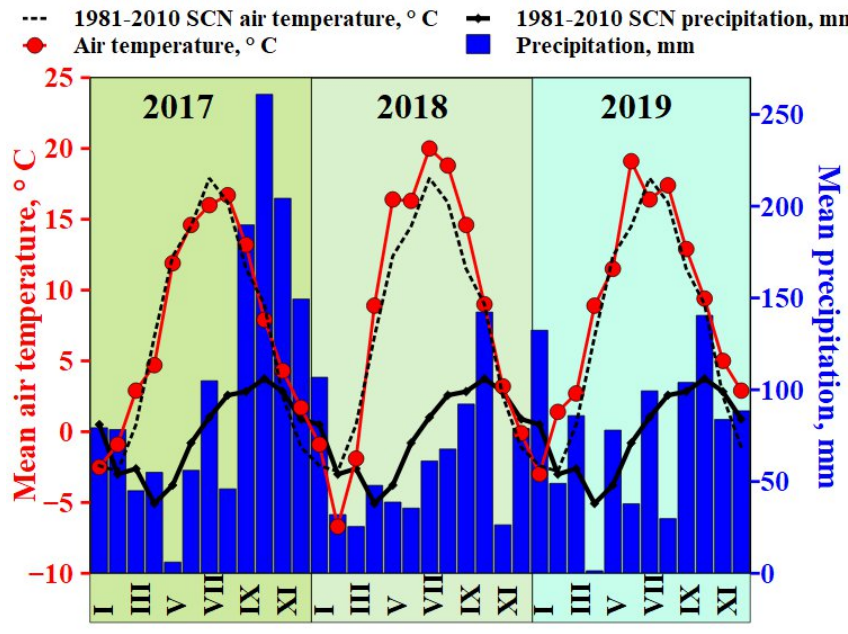
Figure 1. Mean monthly air temperature (°C) and precipitation (mm), according to the meteorological data from the Lithuanian Hydrometeorological Service under the Ministry of Environmental.